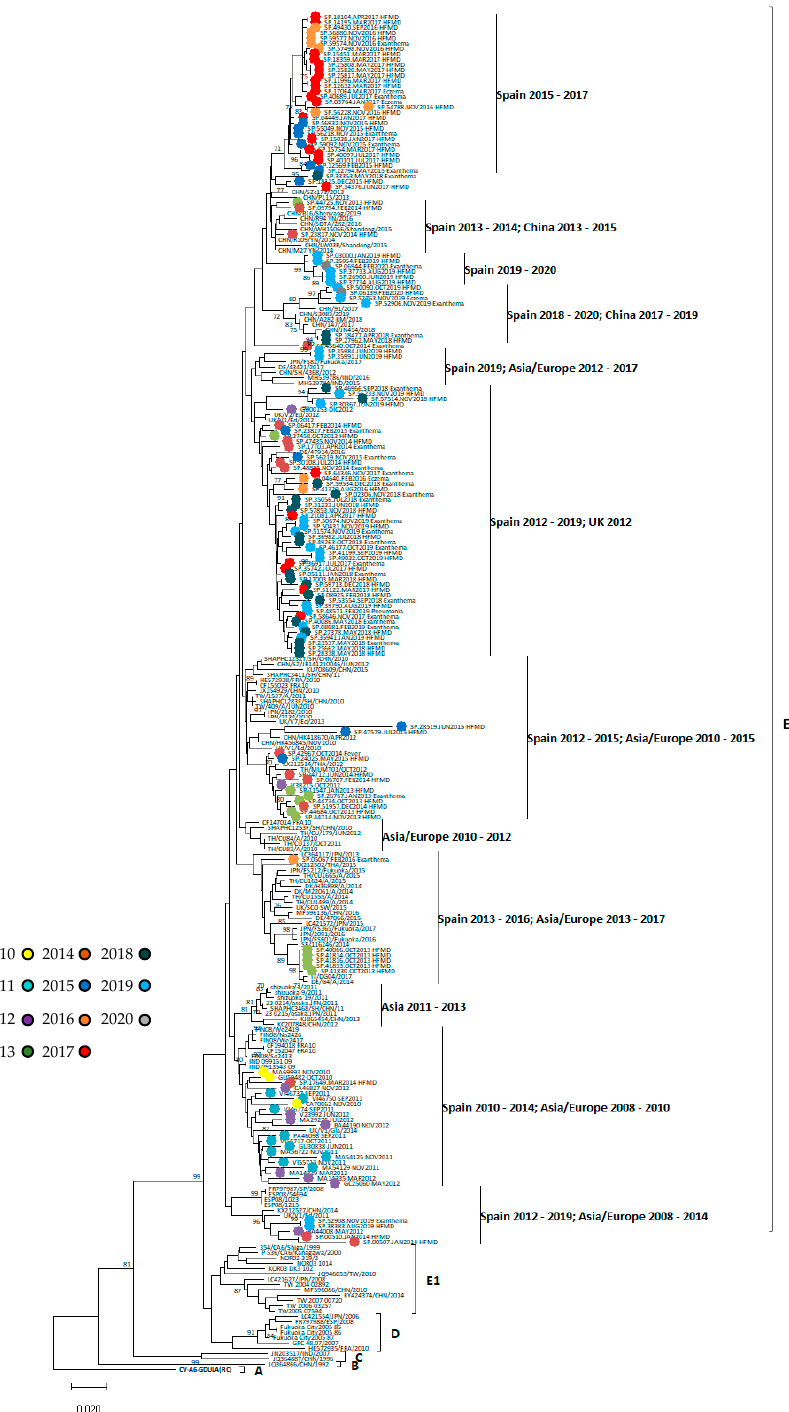
Figure 3. Phylogenetic tree of 3 (cid:48) VP1 region with CVA6 sequences from 1992–2020 classified into six linages, A-E2. Trees were reconstructed using the neighbour-joining method and the maximum composite likelihood model. Tree was rooted with the prototype sequence Gdula (GenBank accession number AY421764). Bootstrap resampling (1000 replicates) was used to determine robustness of groupings. Values of >70% shown. Spanish sequences obtained in this study were coloured according to year of detection